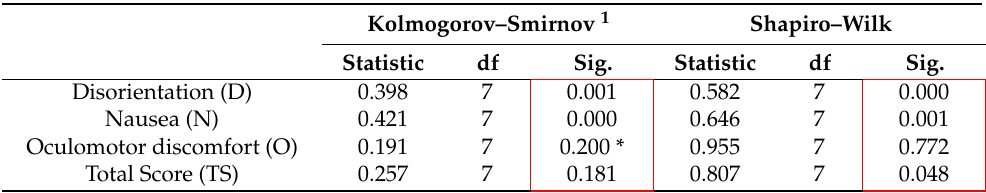
Table 18. Results of normality test for SSQ scores for each subject: post-questionnaires.